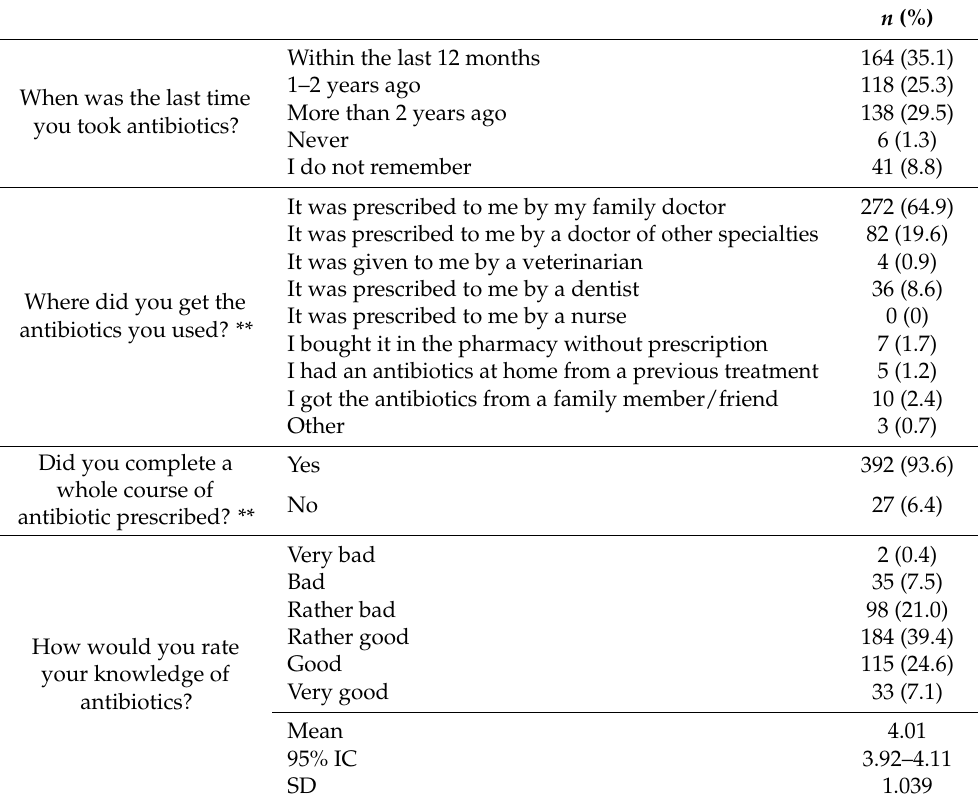
Table 2. Use of antibiotic therapy by study participants ( n =